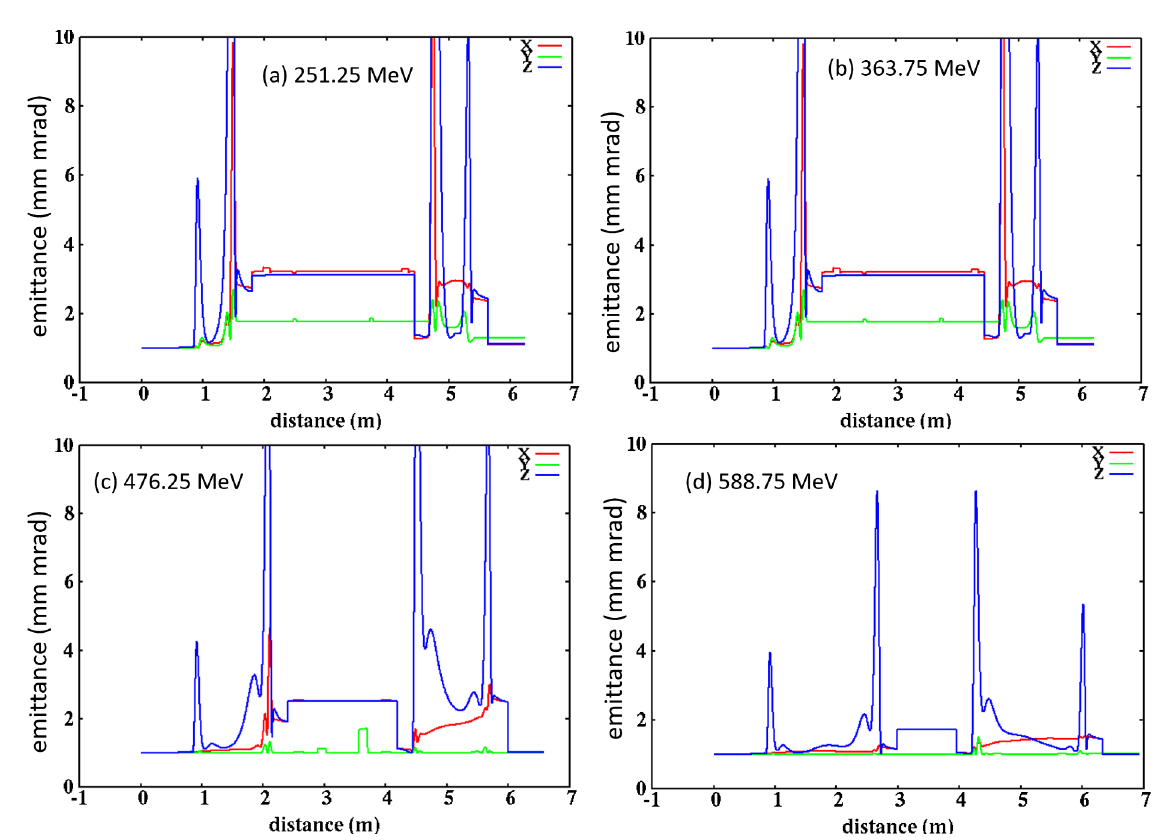
FIG. 14. Proton beam transverse and longitudinal RMS emittance evolution through the phase shifter (Table III) with 251.25 MeV (top left), 363.75 MeV (top right), 476.25 MeV (bottom left), 588.75 MeV (bottom right) kinetic energy, initial Waterbag distribution, and 40 mA